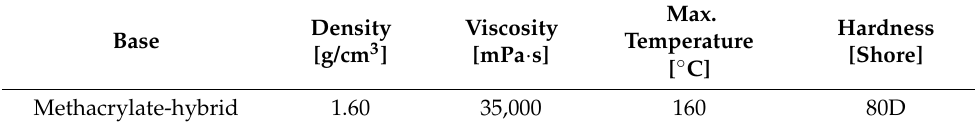
Table 2. Parameters of Polytec PT UV 2133